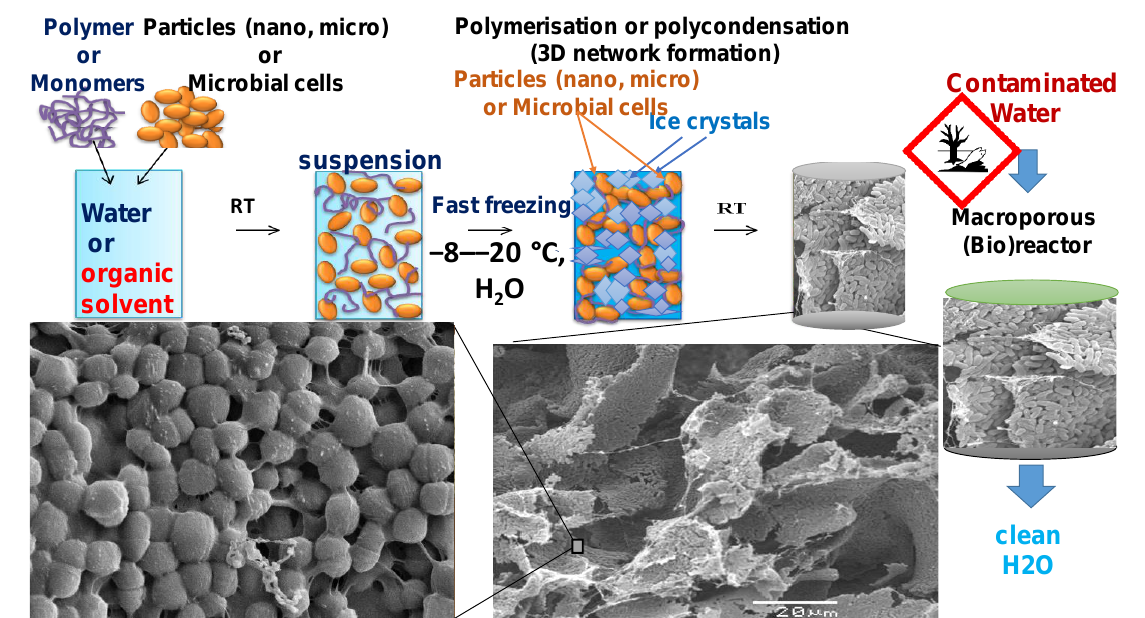
Figure 2. Scheme of preparation of cryogels from bacterial cell suspension and cross-linking polymer(left to right), mixing of components, freezing of the bacteria suspension and thawing step; illustration of the morphology of macroporous structure(SEM microphotograph at low and high magnification). The left part illustrates the principle of the water bioremediation process by macroporous bioreactor in flow-through mode.